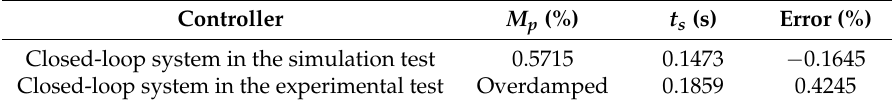
Table 4. Transient responses of the buck-motor system in closed-loop with